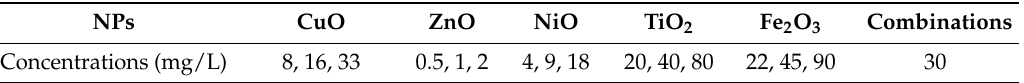
Table 1. The three levels of each nanoparticle used in 30 combinations for the study of binary mixture. NPs CuO ZnO NiO TiO 2 Fe 2 O 3 Combinations Concentrations (mg/L) 8, 16,